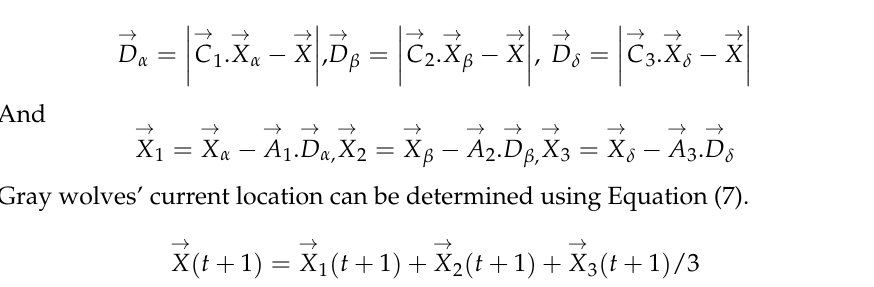
Figure 4. ( a ) 2D and ( b ) 3D position vectors, as well as their possible next locations [30].